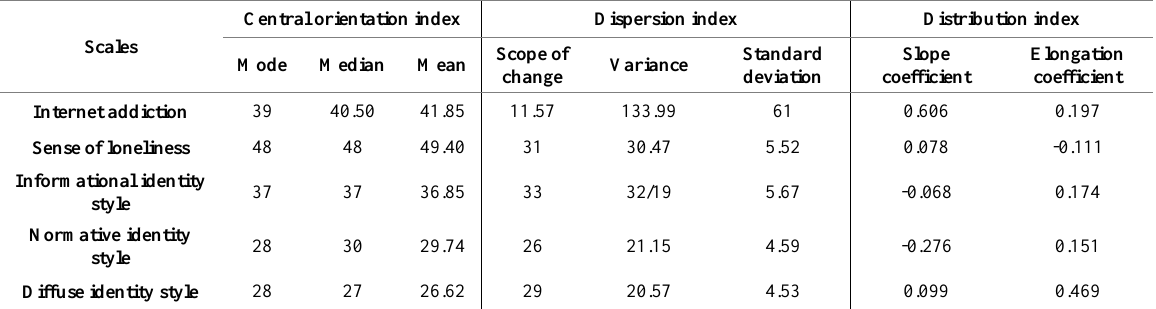
Table 1. Statistical indicators of identity styles and internet addiction scores